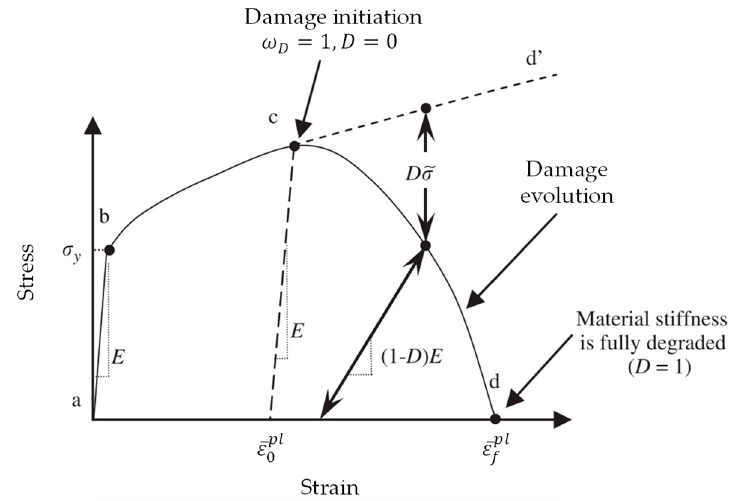
Figure 2. Typical uniaxial stress-strain response of a metal specimen in accordance to [35].